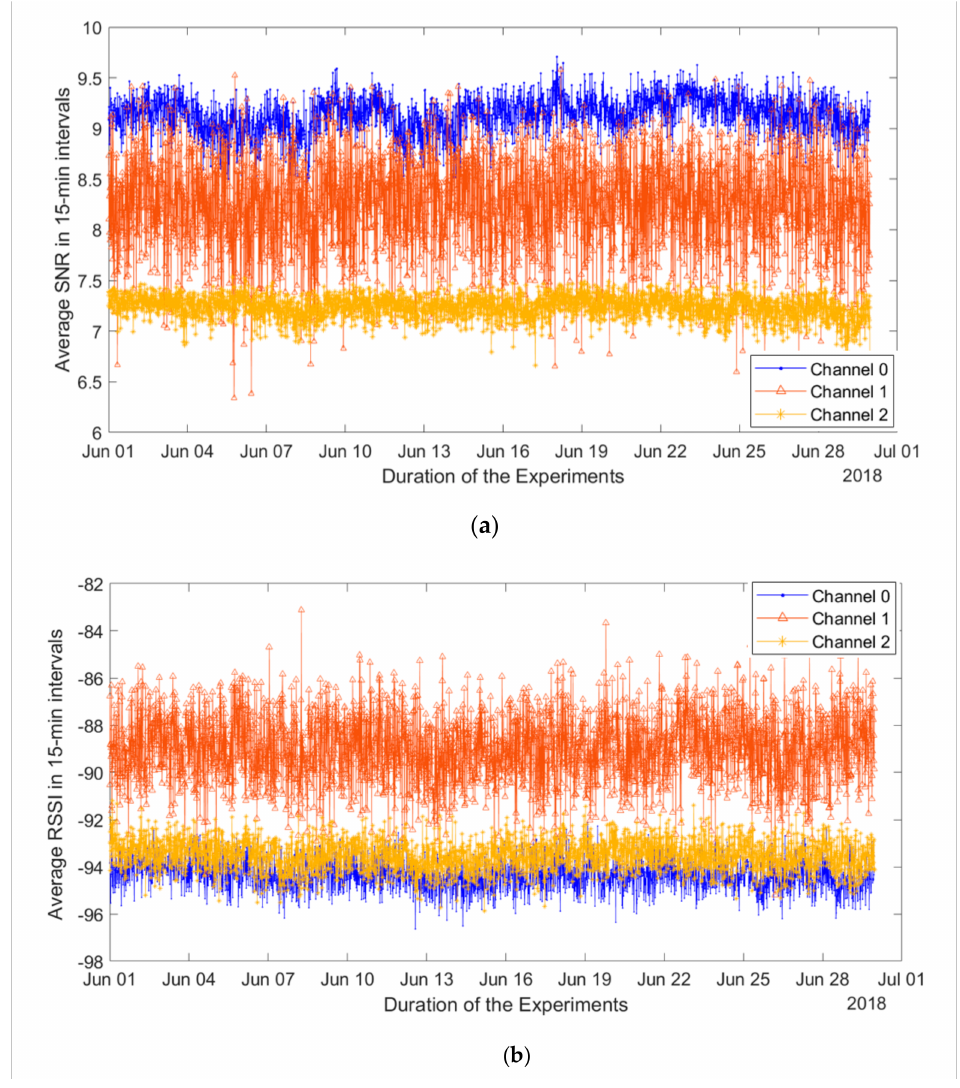
Figure 9. Average signal-to-noise ratio (SNR) and radio signal strength indicator (RSSI) over the channels measured by LoRaWAN gateway. ( a ) Average SNR over all the nodes in each channel with 15-min interval for June 2018. ( b ) Average RSSI over all the nodes in each channel with 15-min interval for June